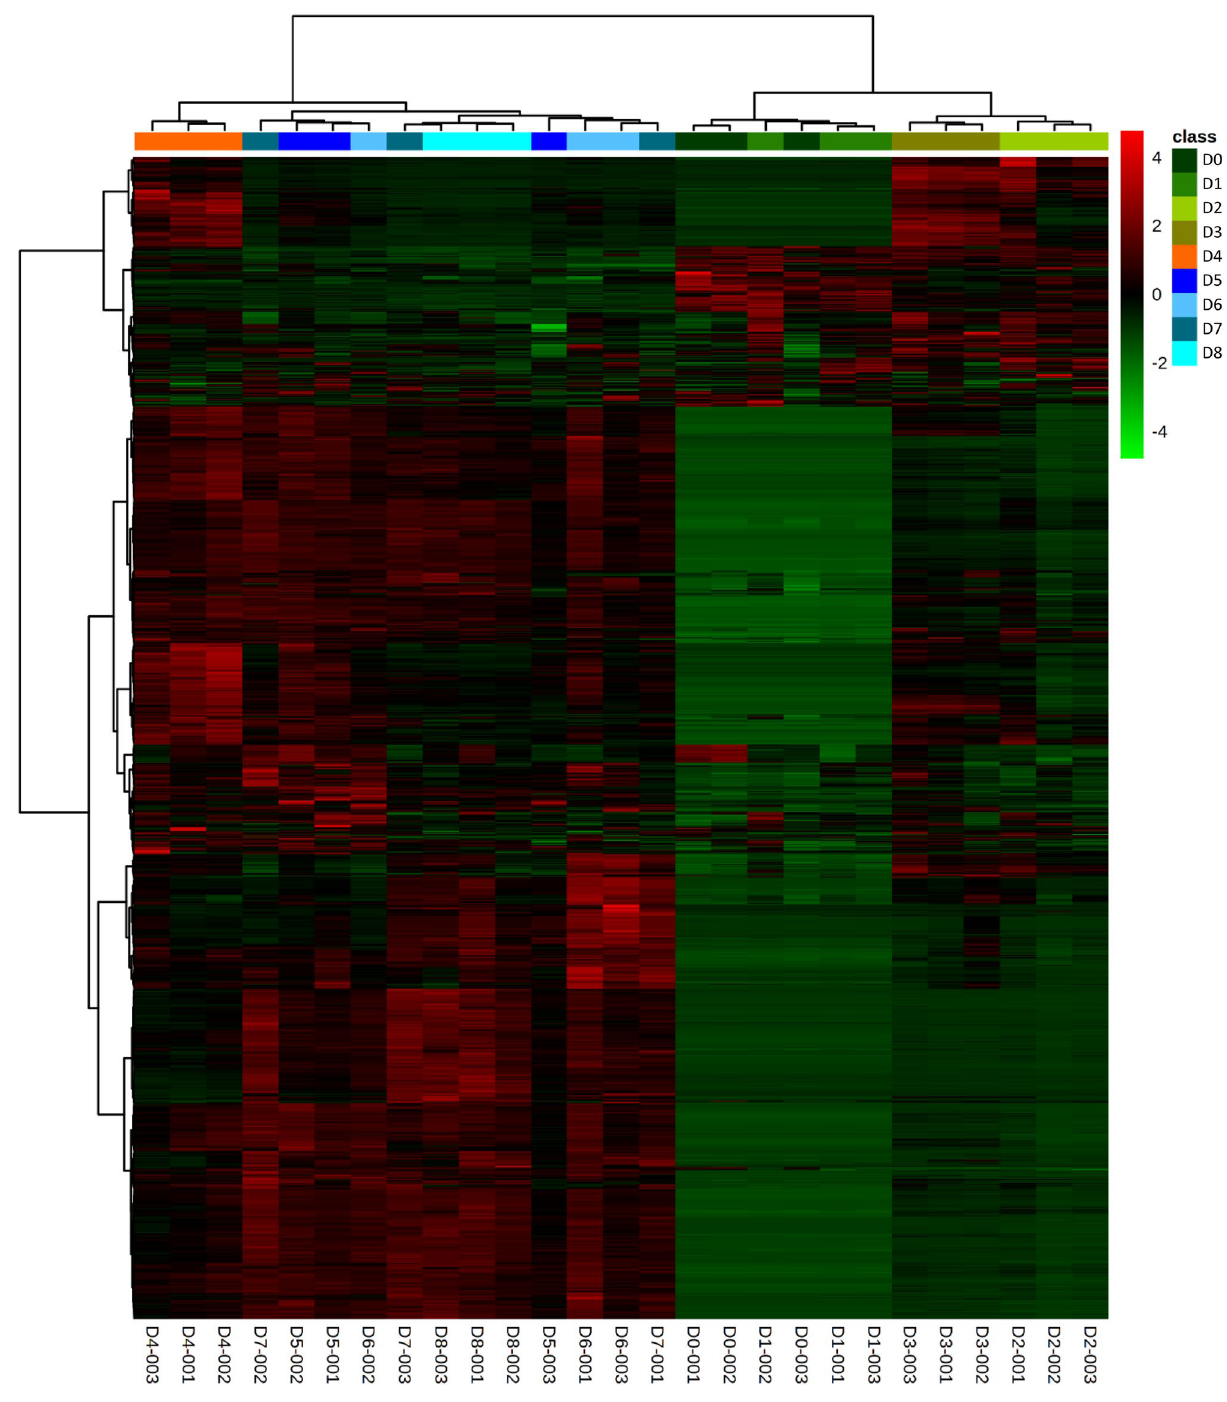
Figure 4. Heat map analysis of metabolite features detected in all analytical platforms for all fermentation days (MetaboAnalyst 5.0 68 ). The color spectrum ranging from red to green indicates the range of high to low signal intensities for each